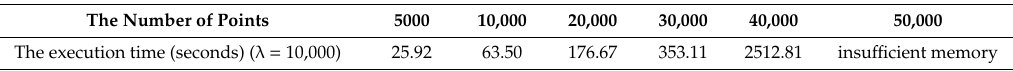
Table 2. The execution time by L1 trend filtering under di ff erent numbers of